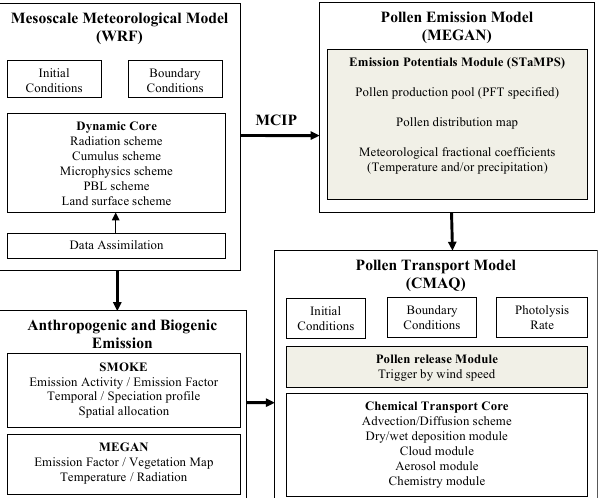
Fig. 1. Flowchart of a regional WRF-MEGAN-CMAQ air-quality modeling framework with pollen emission and transport modeling highlighted.